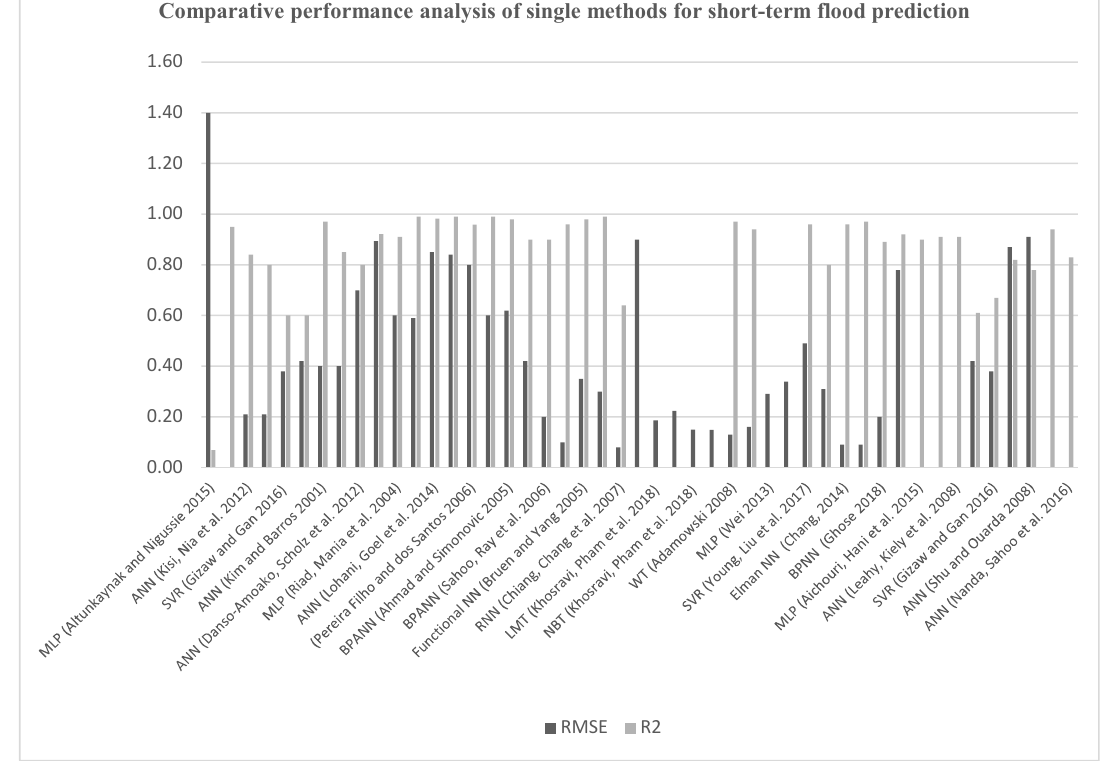
Figure 7. Comparative performance analysis of single methods of ML for short‐term flood prediction using R 2 and root‐mean‐square error (RMSE).